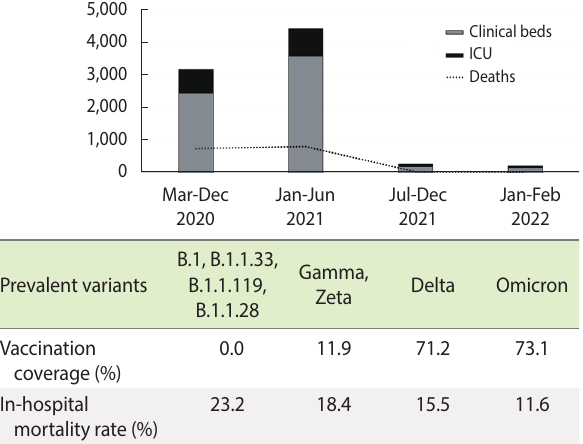
Figure 1. Hospitalizations and in-hospital deaths from coronavirus disease 2019 at different phases of the pandemic according to the circulation of severe acute respiratory syndrome coronavirus